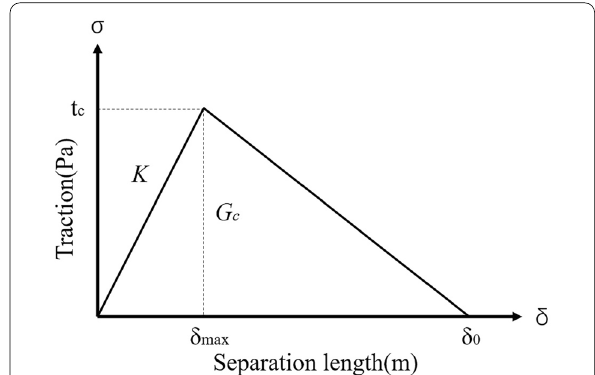
Figure 8 Cohesive zone model base on traction-separation